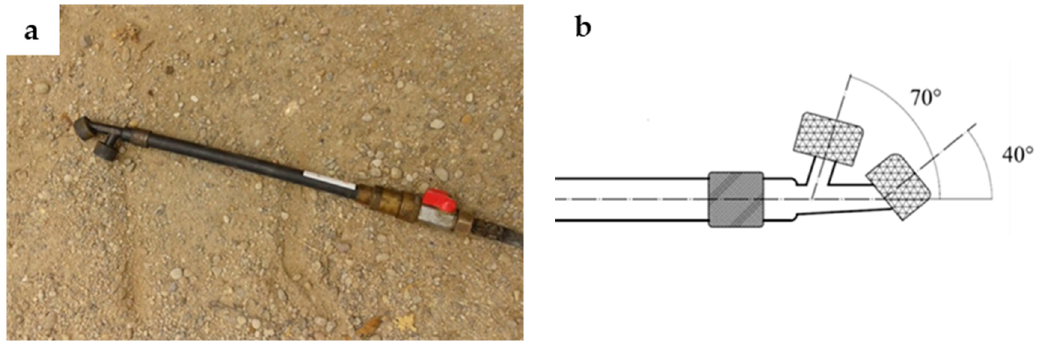
Figure 2. Flat-fan spray lance ( a ). Position of the twin flat-fan nozzles ( b ).